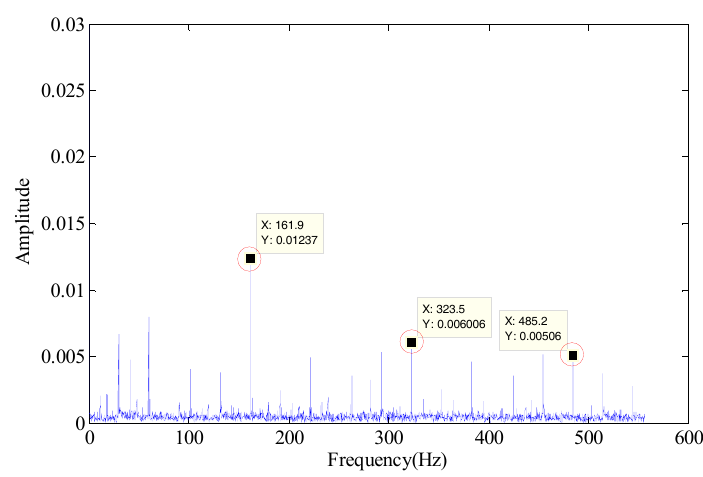
Figure 25. Envelope spectrum of the proposed method.